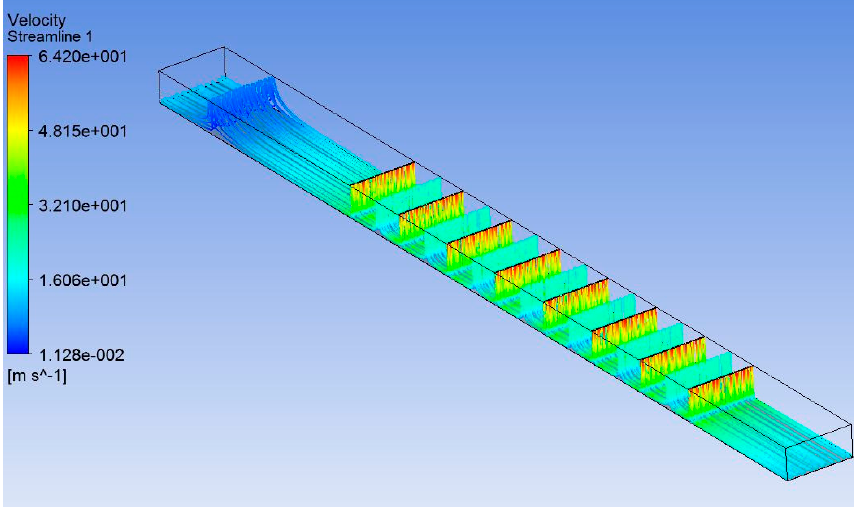
Figure 21. Streamlines in the configuration #2 with 8 slots.